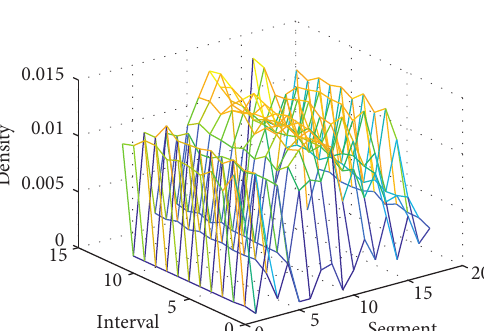
Figure 17: The VSL-integrated